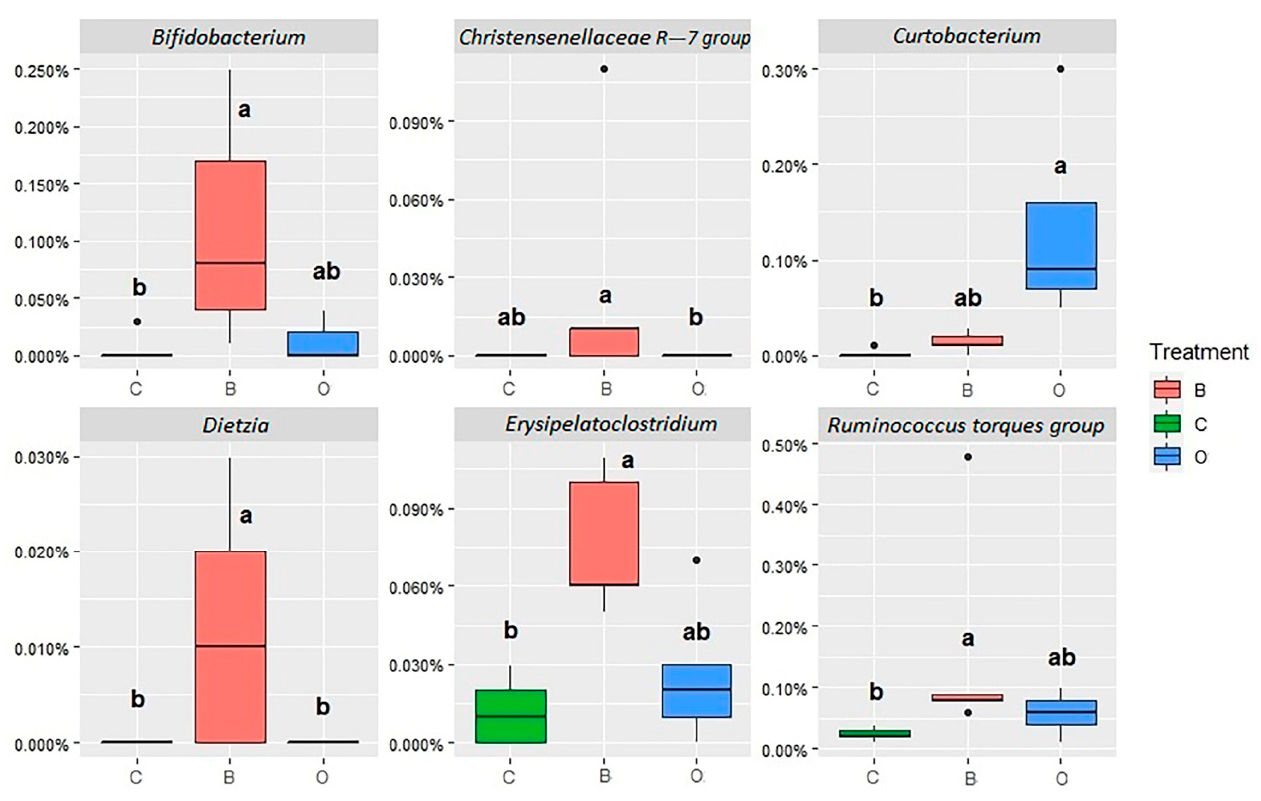
Figure 2. Boxplots showing significant changes in the genera of the jejunum contents. C: Control: maize-based diet; B: barley-based diet; O: oat-based diet. Results of Kruskal–Wallis test and the post hoc Dunn’s multiple comparisons test with Bonferroni correction. a,b values marked with different lowercase letters were significantly different ( p < 0.05). Results between 0.05 and 0.1 (0.05 < p < 0.10) were considered as a trend ( T ). Dots represent the outlier values.